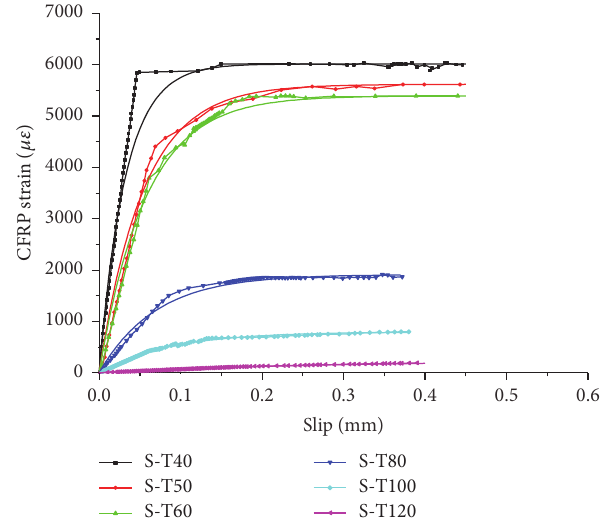
Figure 8: Relationships of CFRP strain and slip at loaded